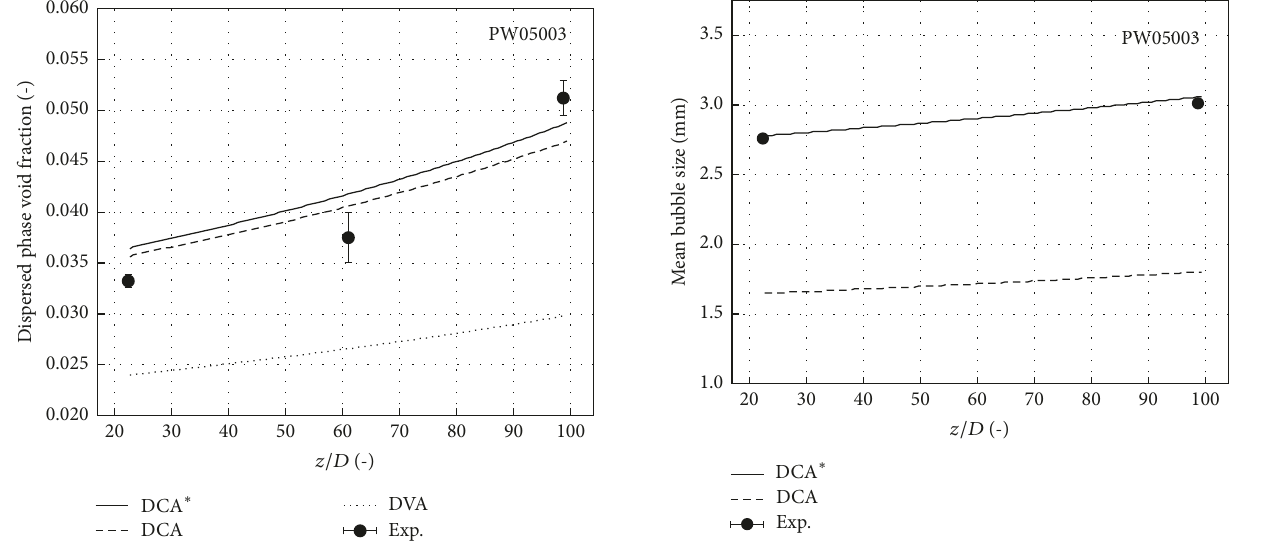
Figure 7: Comparison of void fraction axial evolution for the different drag approaches.